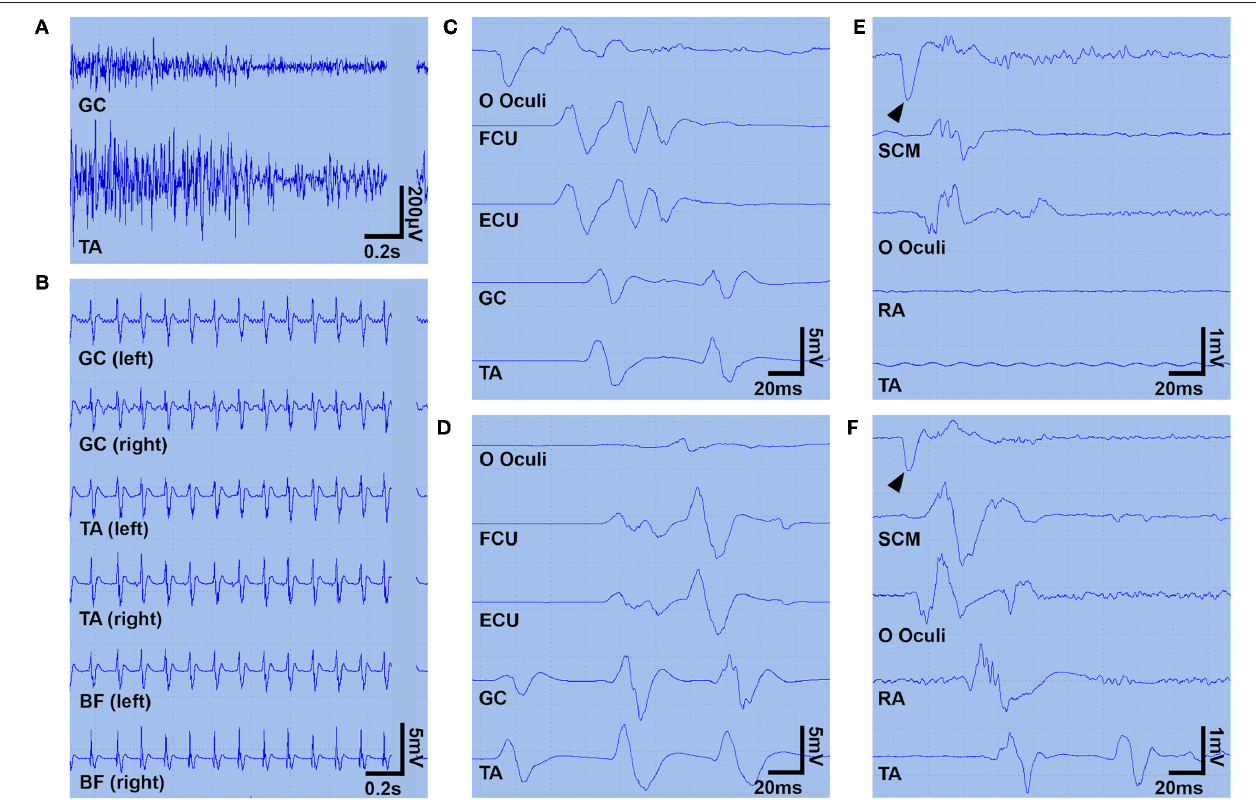
FIGURE 1 | Surface EMG findings. A surface EMG (A–D) was recorded on day 4 under continuous infusion of midazolam (0.1 mg/kg/h) and propofol (1.0 mg/kg/h). Panel (A) shows the continuous simultaneous co-contraction of agonist and antagonist muscles at rest. Panel (B) shows ∼ 9Hz rhythmic bilaterally synchronous brief muscle contractions in the lower limbs (manifesting as periodic myoclonic jerks). Panels (C,D) show two spreading patterns descending from the facial muscles (C) or ascending from the leg muscles (D) . Myoclonic jerks were also triggered by sudden sound or touch (not shown). Another surface EMG was recorded on day 60, during a continuous infusion of dexmedetomidine (0.45 µ g/kg/h) (E) and 90min after discontinuation of the dexmedetomidine (F) to explore the inhibitory effect of dexmedetomidine on hyperexcitability of the alpha motoneurons to the jaw jerk reflex maneuver. Panel (E) shows that the tapping of the lower jaw (arrowheads) triggers muscle contraction limited to the SCM and OO, but panel (F) shows muscle contractions propagating into the TA. In panels (A,C–F) , a surface EMG was obtained from the left-sided muscles. BF, biceps femoris; ECU, extensor carpi ulnaris; EMG, electromyogram; FCU, flexor carpi ulnaris; GC, gastrocnemius; OO, orbicularis oculi; RA, rectus abdominis; SCM, sternocleidomastoid; TA, tibialis